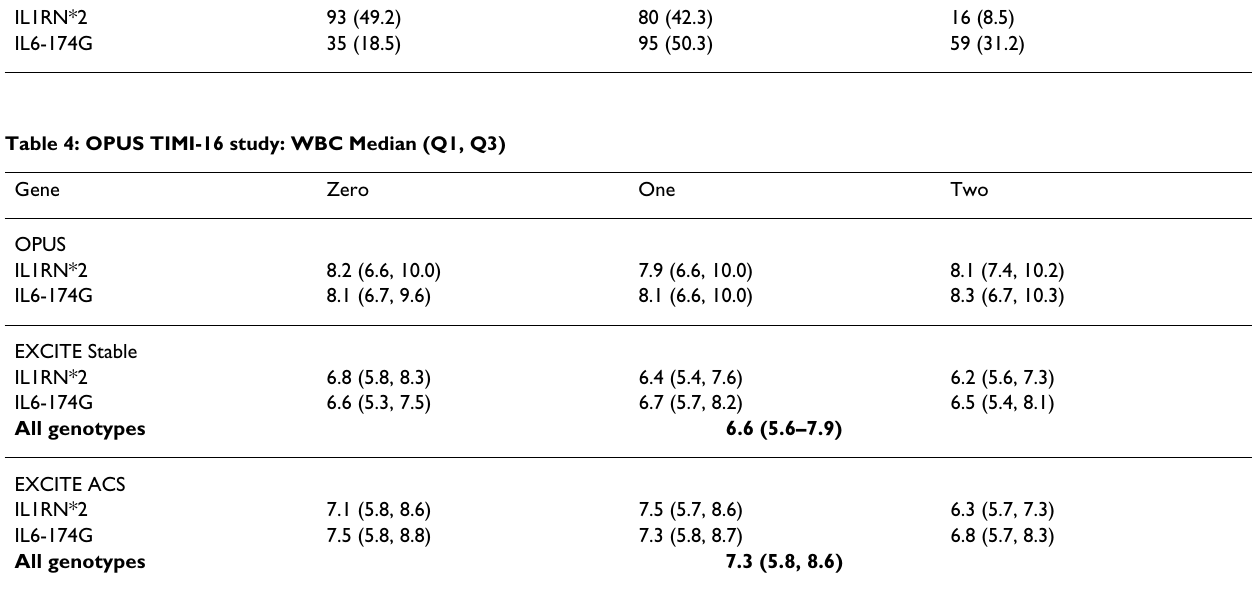
Table 3: EXCITE study: Distribution of genotypes n (%) Zero One Two